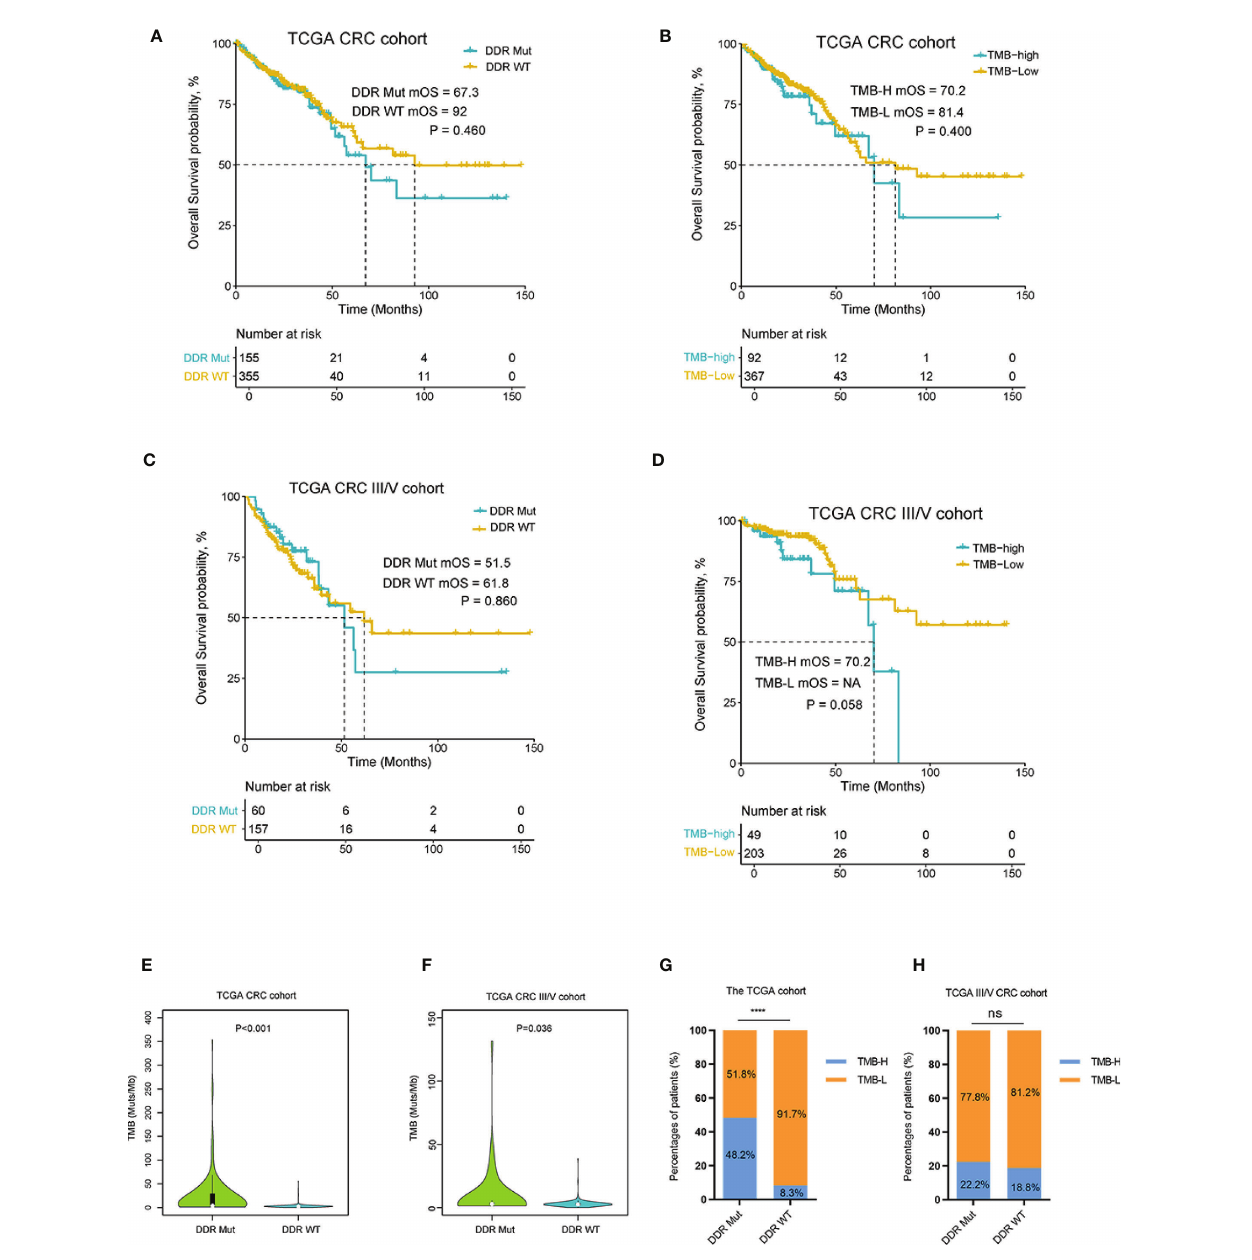
FIGURE 3 | DNA damage repair (DDR) mutation may be a speci fi c biomarker to predict the ef fi cacy of immune checkpoint inhibitor (ICI) immunotherapy in colorectal cancer (CRC). (A) Kaplan-Meier curves of overall survival in the The Cancer Genome Atlas (TCGA) CRC cohort and (B) the TCGA III/V CRC cohort for DDR Mut and WT groups. (C) Kaplan-Meier curves of overall survival in the TCGA CRC cohort and (D) the TCGA III/V CRC cohort for the TMB-High and TMB-Low groups. (E, F) Distribution of TMB in the DDR Mut and WT groups (E) in the TCGA CRC cohort and (F) the TCGA III/V CRC cohort. (G, H) The proportion of TMB-High and TMB-Low in DDR Mut and WT groups (G) in the TCGA CRC cohort and (H) the TCGA III/V CRC cohort. ****P < 0.0001, ns, no signi fi cant